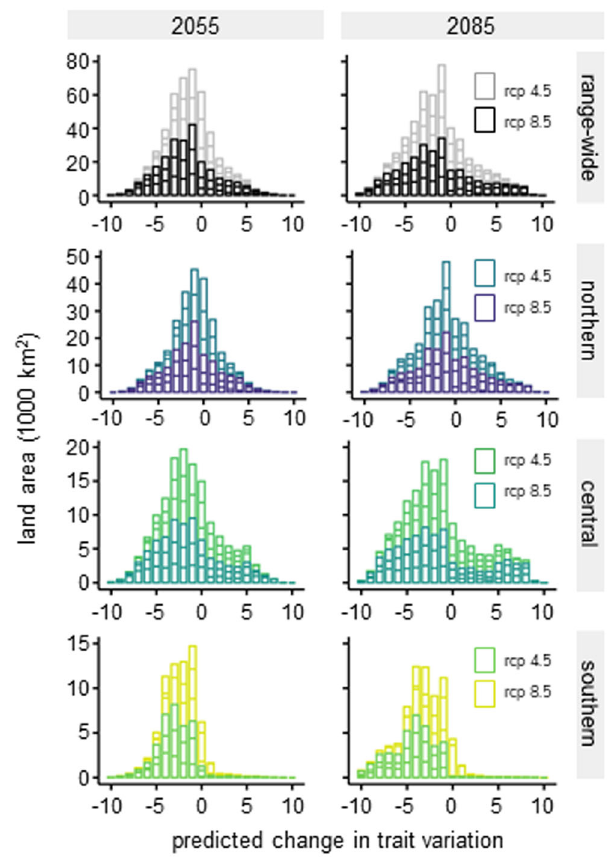
Fig. 2 Predicted changes in phenological trait variation (decile richness) on the landscape (area) across the P. angustifolia species range, three genetic provenances, two future time periods (2055 and 2085), and two relative concentration pathways (rcp 4.5 and 8.5). The lighter color lines within each bar represents rcp 4.5 predictions while the darker color within each bar represents rcp 8.5 predictions. Lines across each bar represent the predictions made from each of the three Atmosphere and Ocean General Circulation/Climate models (AOGCMs) for each time and rcp. Zeros only represent no change in trait variation if there was variation to begin with (i.e., they do not represent area of unsuitable climatic conditions). Positive values indicate gains in trait variation.